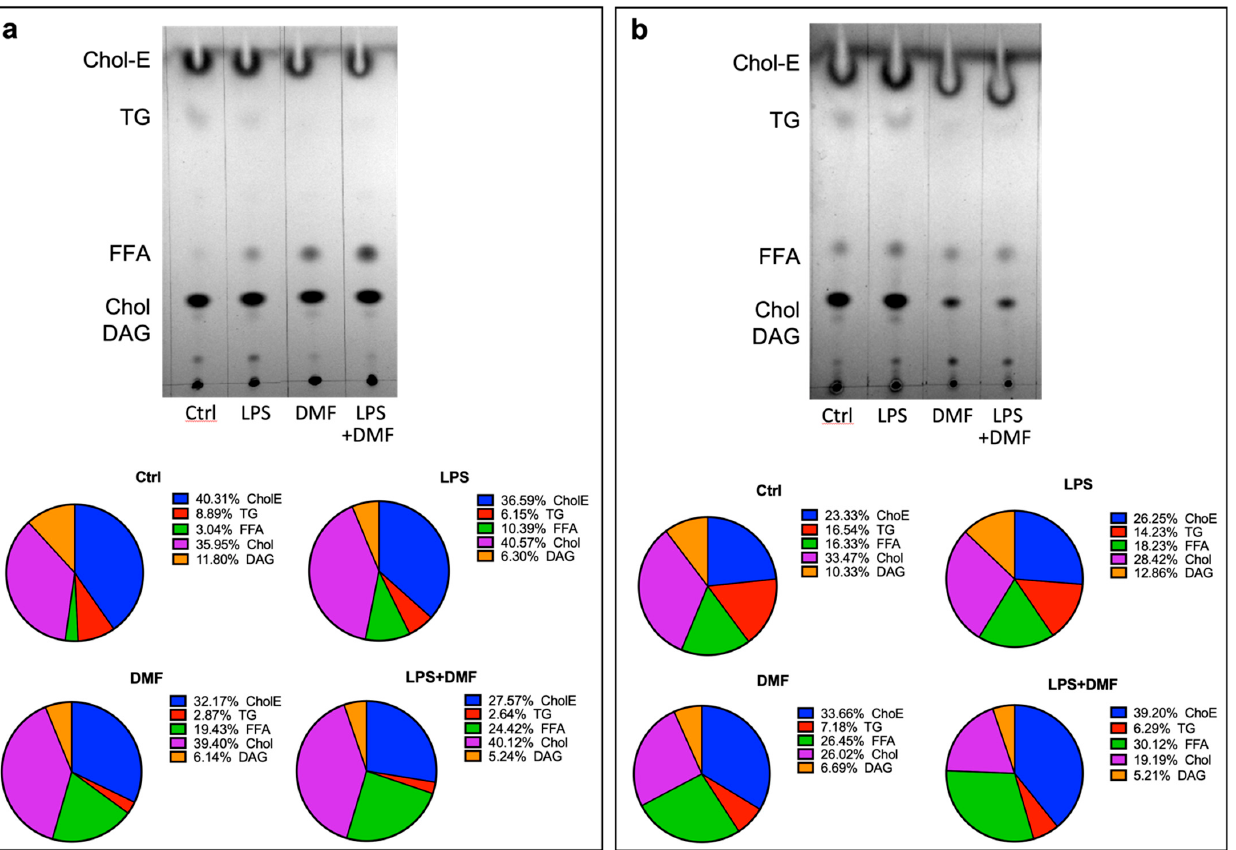
Figure 8. LDs contents were evaluated by TLC in Oli neu cells at different experimental conditions: cells treated with vehicle (Ctrl), LPS 1 μ g/mL, DMF 25 μ M and LPS 1 μ g/ μ L + DMF 25 μ M after 48 h ( a ) and 120 h ( b ). Representative images were selected from three independent experiments. Pie charts represent the percentages of the different lipid species analysed (Chol-E, TAG, FFA, Chol, DAG) under the four experimental conditions.